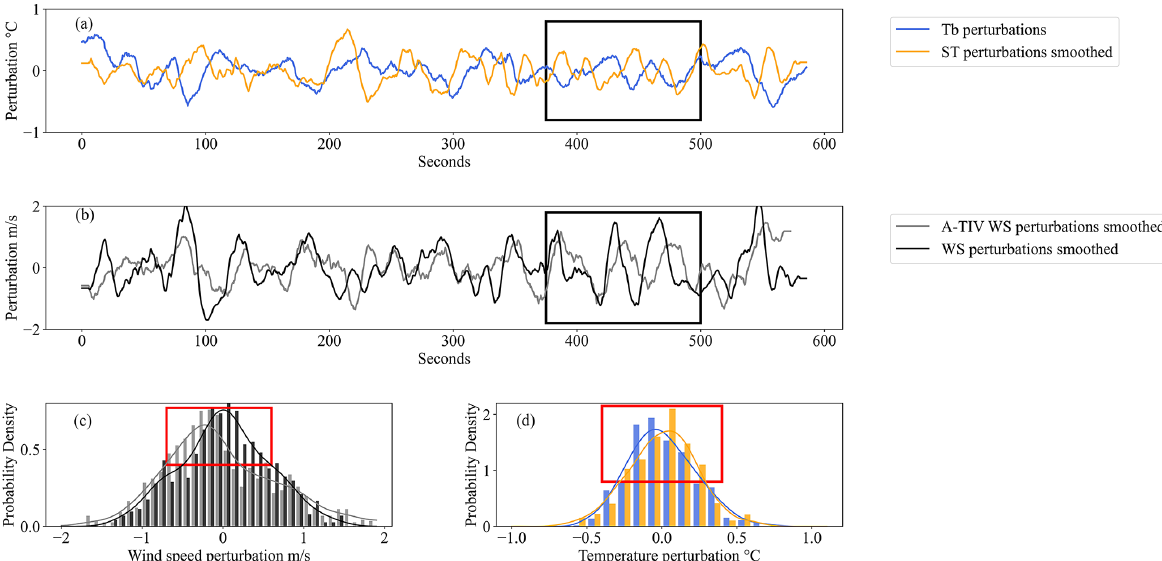
Figure 9. TURF-T1 wind speed and temperature perturbations – TURF-T1 comparison of spatial average (15m × 15m) brightness temper- ature ( T b ) perturbations ( a , blue), with sonic temperature (ST) perturbations ( a , orange), and the areal A-TIV wind speed perturbations ( b , grey) with the measured wind speed perturbations from the eddy covariance/sonic anemometers ( b , EC – black). Panels (a) and (b) show the timing of the measured temperature perturbations – see black square. The red rectangles in panels (b) and (c) show the differences in distribution of perturbations. The area of ∼ 15m × 15m for the calculation of the spatial average perturbations was picked slightly upwind of the sonic